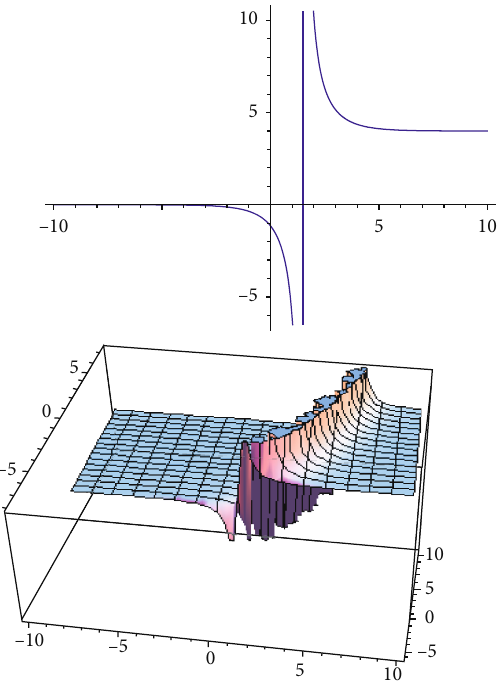
Figure 6: 2D and 3D graphics for hyperbolic traveling wave solution (34) at f β = 0 : 5, r = 1, q = 1, c = 1 g